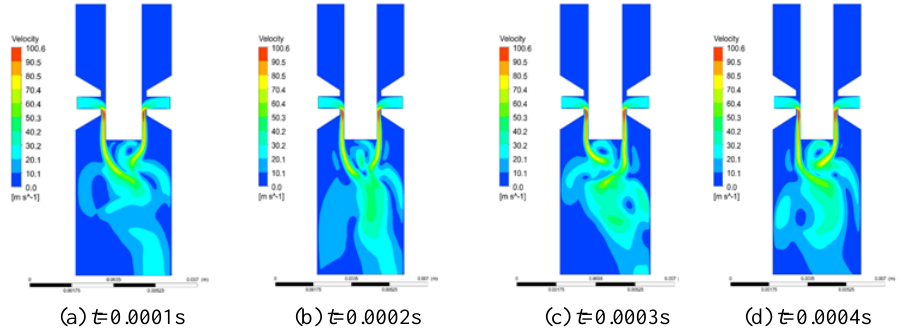
Figure 5. Velocity nephogram in one oscillating period.